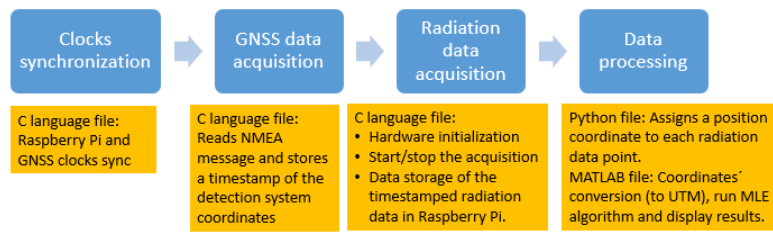
Figure 6. Software